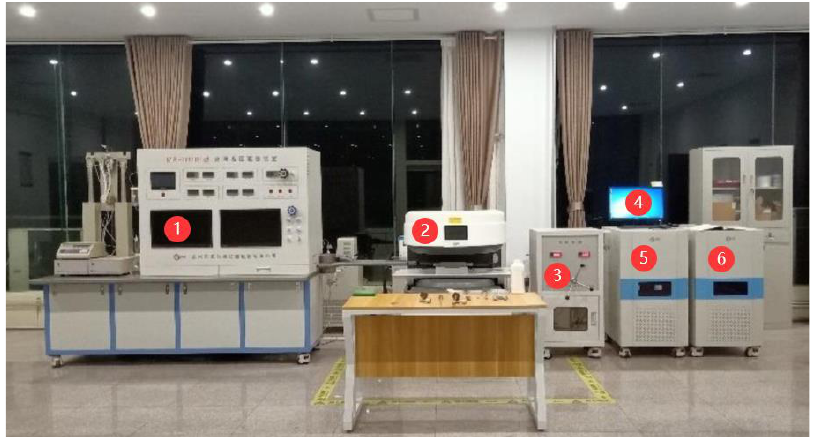
Figure 1. High temperature and high-pressure NMR visualization experimental platform (MacroMR12-150H-l). Table 1. Statistics of various water saturations by the LF-NMR test for coal samples from Dahe block, Guizhou (confining pressure is 8 MPa, outlet pressure is 0.1